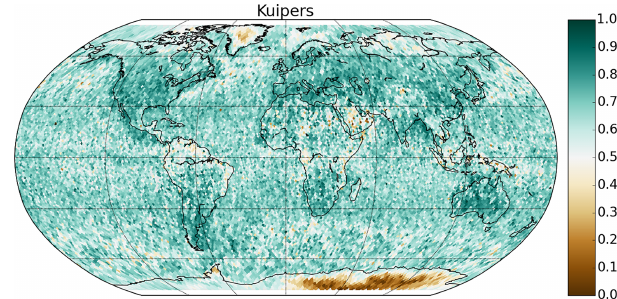
Figure 10. Kuipers score for the CLARA-A2 cloud mask achieved after filtering the CALIOP cloud mask with the cloud optical thick- ness value of 0.225. Same underlying matchup data set as in Fig. 2. Results are presented in a Fibonacci grid with 75km resolution.